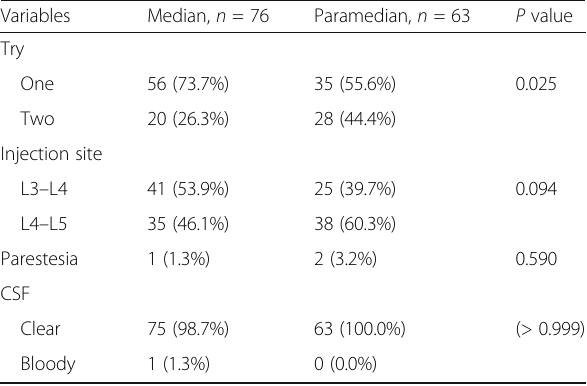
Table 2 Comparison between spinal anesthesia techniques between two groups of study